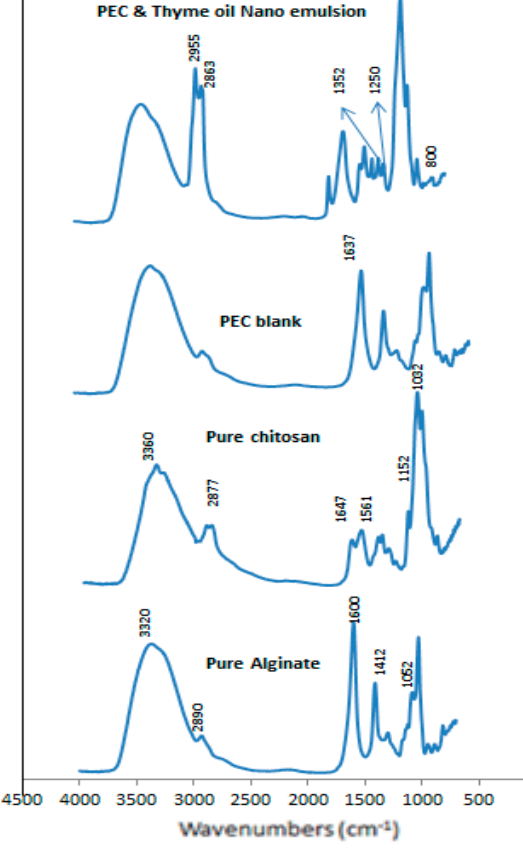
Figure 3. FTIR Figure 3. FTIR results.